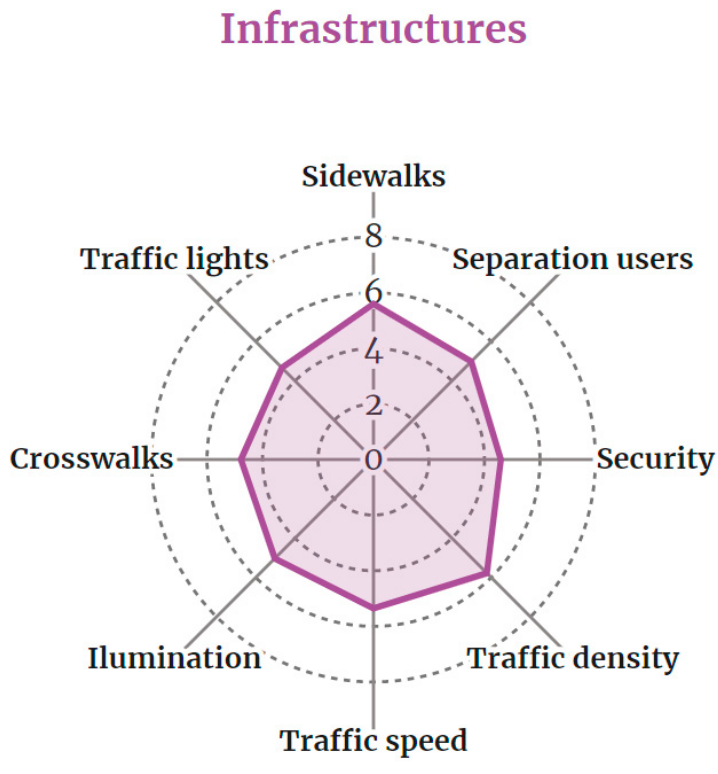
Figure 2. Assessment of roadway features by Dominican pedestrians.